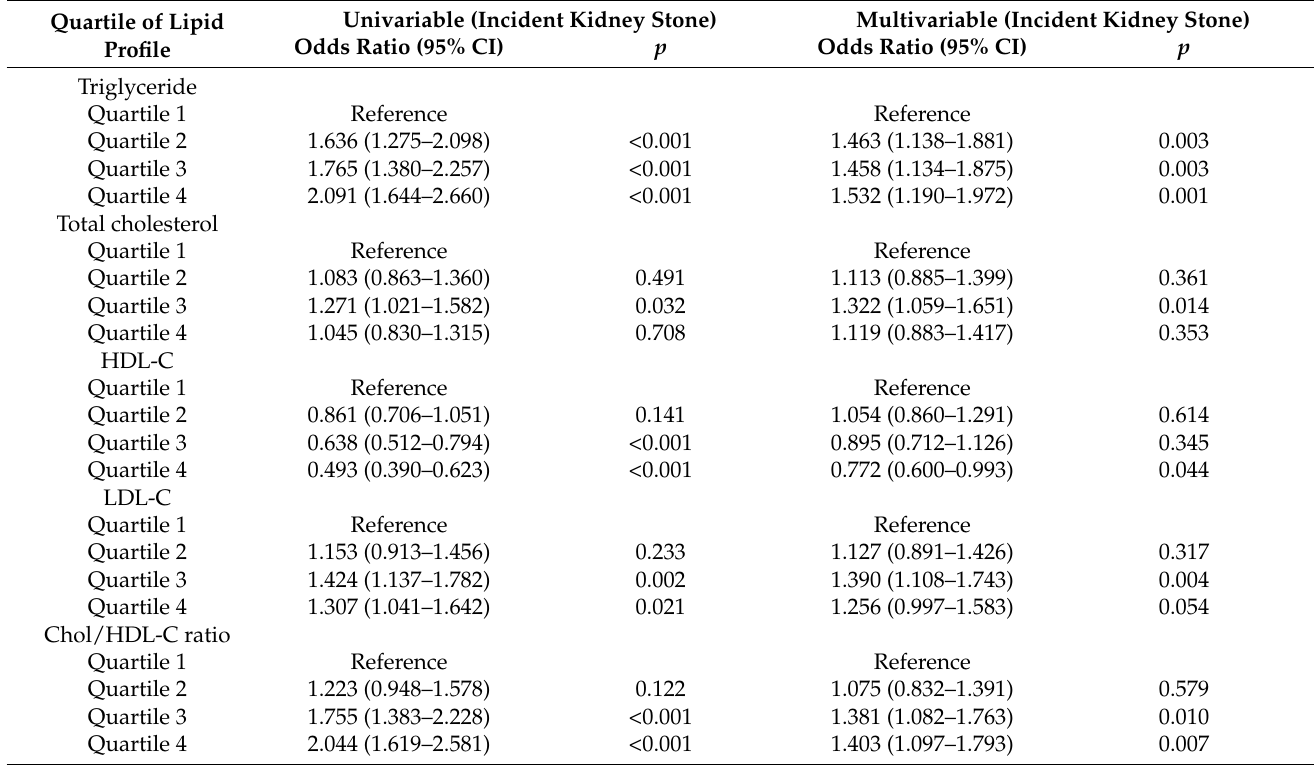
Table 4. Association of quartile of lipid profile and incident kidney stone disease using logistic regression analysis in study participants without baseline kidney stone disease ( n = 25,189).